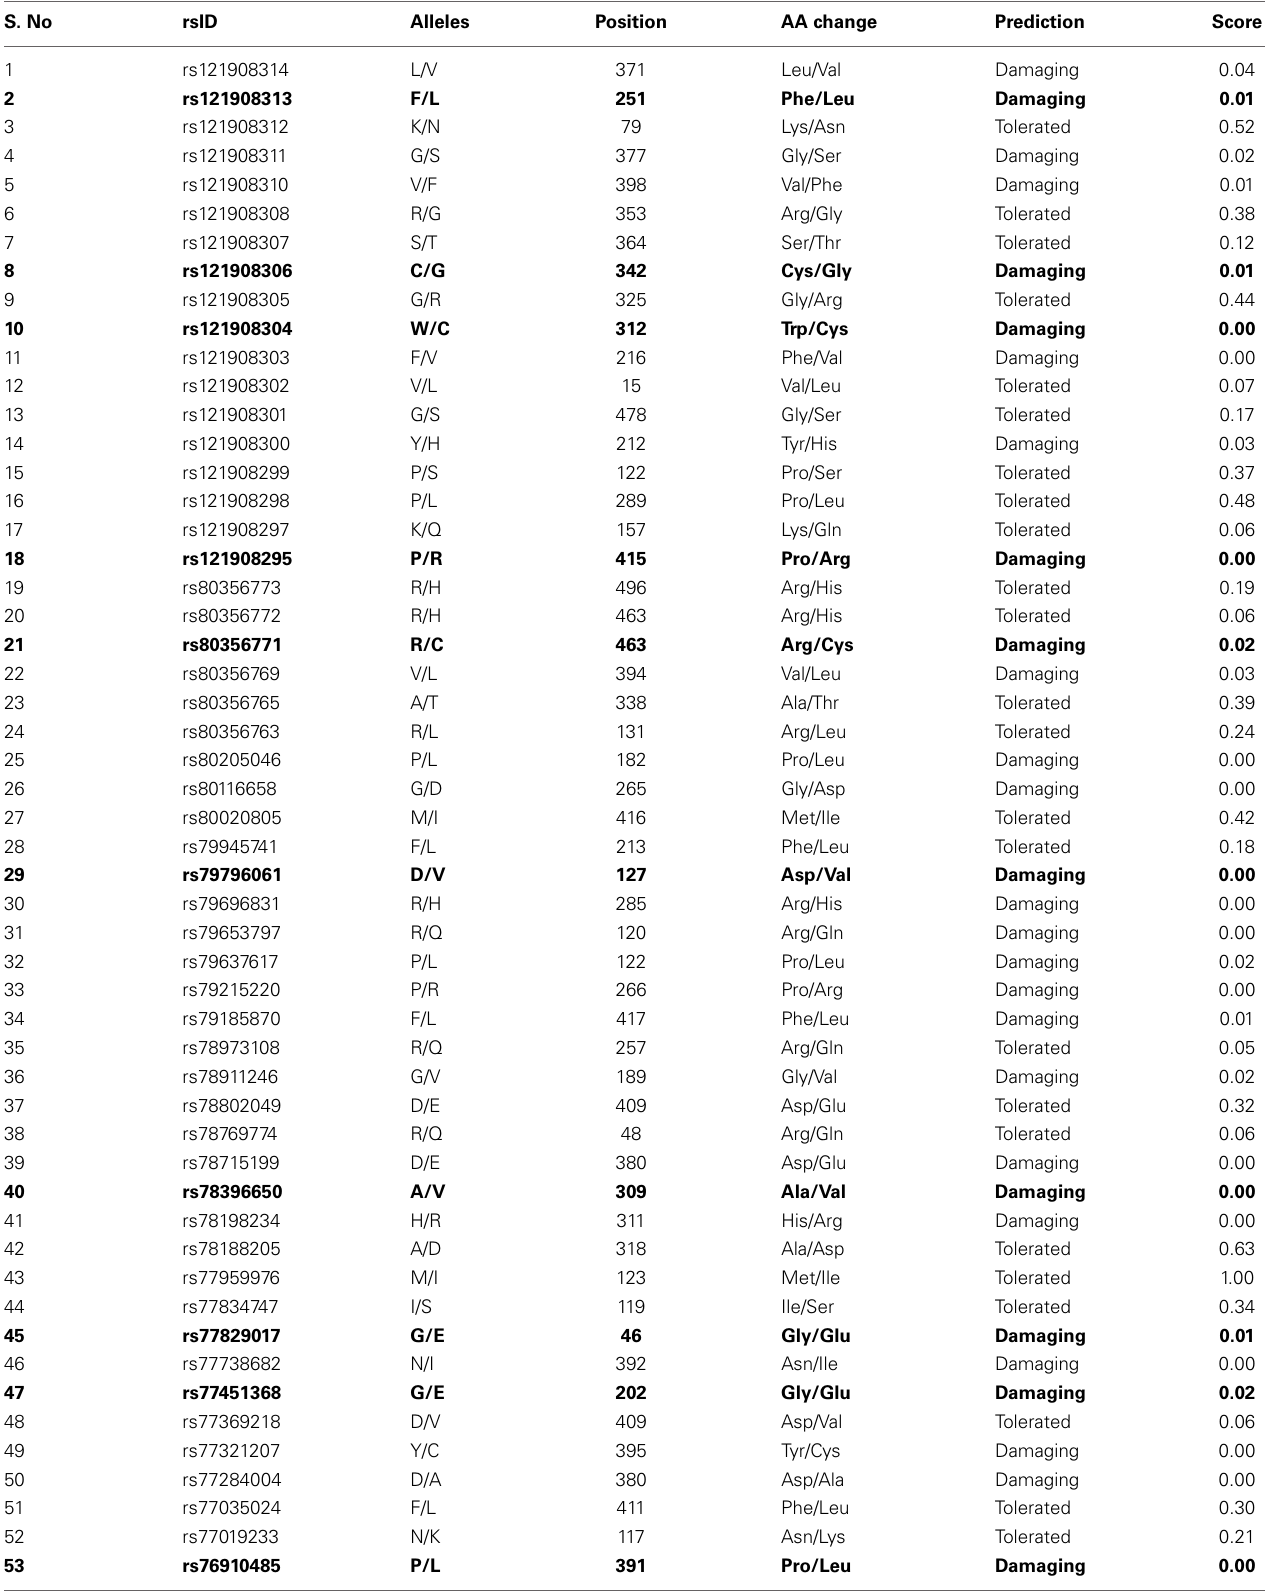
Table 1 | Tolerated and deleterious nsSNPs using